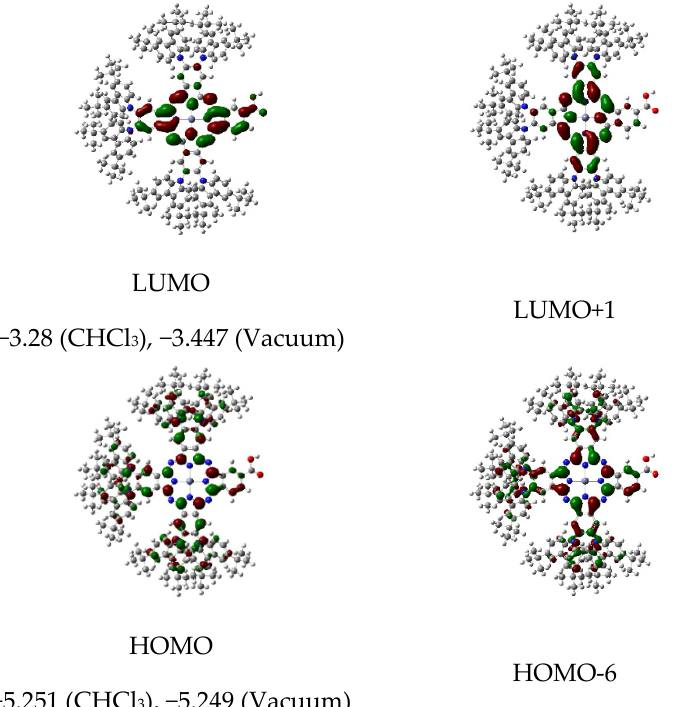
Figure 2. The Gouterman’s molecular orbitals of tCzZnPc1 calculated at CAM-B3LYP / LANL2DZ level of theory, and the calculated values of HOMO and LUMO energy levels in a vacuum and in CHCl 3 .